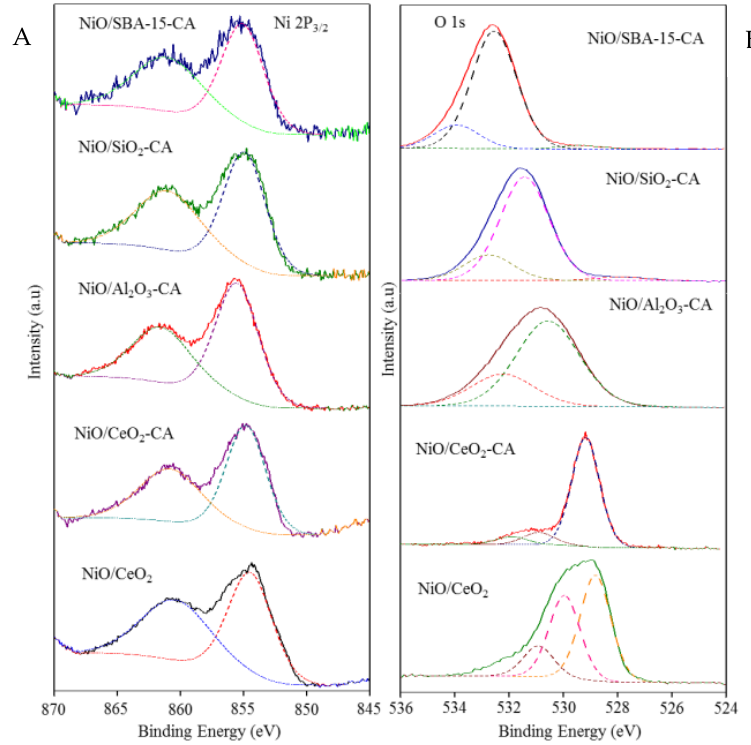
Figure 3. XPS ( A ) Ni 2p and ( B ) O 1s spectra of di ff erent